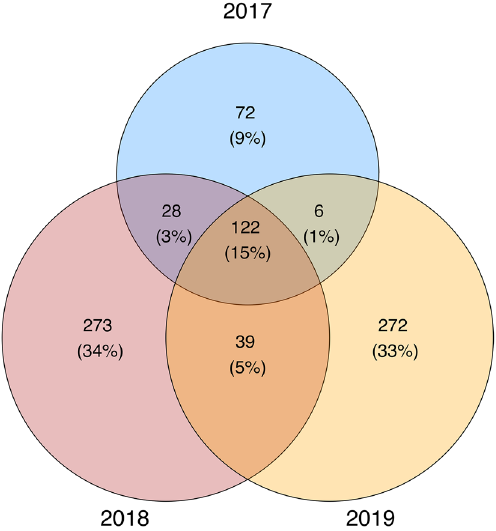
Figure 1. Overlap of ASVs recovered from S. virgatus cloacal microbiomes across three sampling years (2017, 2018, 2019) in May and